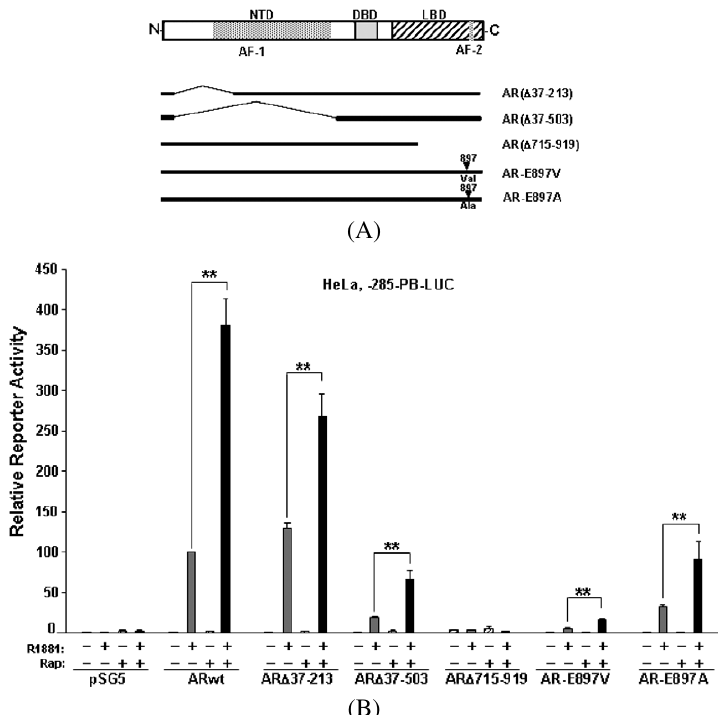
Fig. 4. Mapping the domains in AR that are necessary for the synergistic effect of androgen and rapamycin on AR transcriptional activity. (A) Schematic illustration of AR and AR mutant constructs. The N -terminal domain (NTD), DNA binding domain (DBD) and ligand binding domain (LBD) are indicated. The transactivation function domains, AF-1 and AF-2, are located within the NTD and LBD, respectively, as depicted (regions with dotted black). (B) Mapping the domains of AR that respond to androgen and rapamycin. HeLa cells were co-transfected with -285-PB-LUC and pSG5 with or without wt or mutant AR as indicated. Starved cells were either treated with R1881 (10 − 8 M) and/or rapamycin (100 nM) as indicated, harvested after 48 h and luciferase activities were determined and normalized to the total amount of protein. The values presented are relative to the activity of wt AR in the presence of R1881 (set to 100). The results shown represent three independent experiments in triplicate with ± SEM indicated as error bars. The differences between the groups were evaluated using a one-tailed, paired Student’s t- test, significance is indicated by asterisks, P < 0 . 05 and double asterisk, P < 0 . 01. There were also significant differences in luciferase activity for samples treated with rapamycin compared to non-treated samples for all constructs, except for AR( Δ 715-919); however the activities for these were very close to the basal activity levels observed in the presence of pSG5 and were thus not